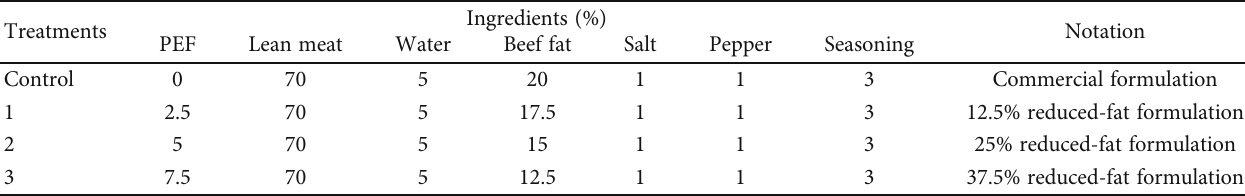
Table 1: Formulation of beef patties containing